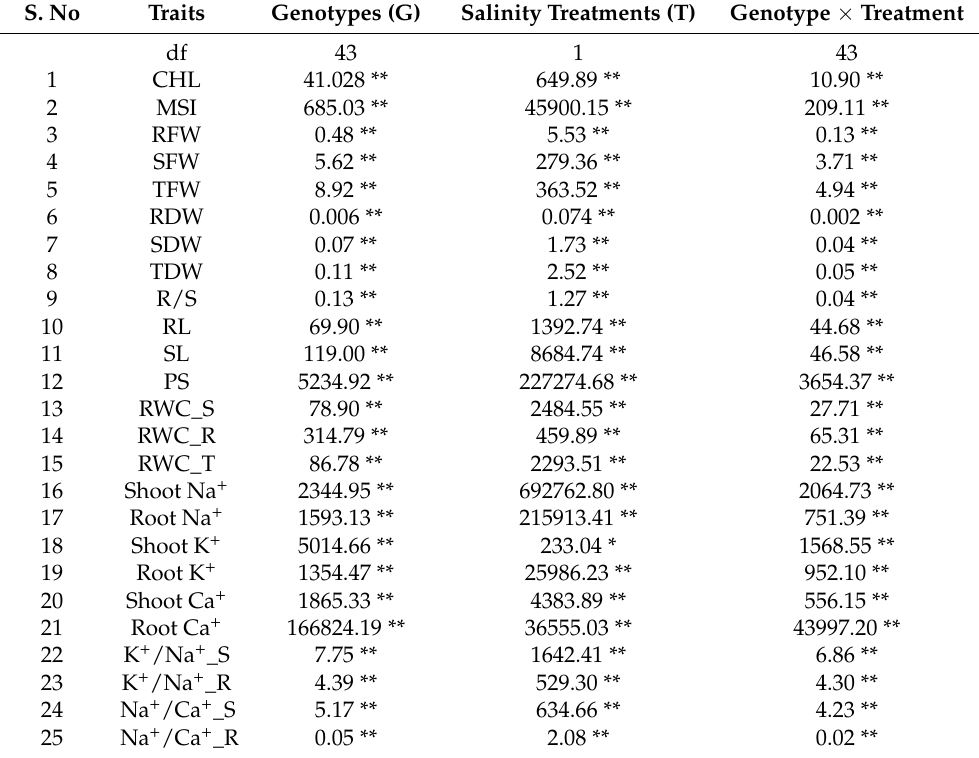
Table 1. Mean squares (MS) of the analysis of variance of all studied traits under salinity stress condition; CHL: chlorophyll, MSI: membrane stability index, RFW: root fresh weight, SFW: shoot fresh weight, TFW: total fresh weight, RDW: root dry weight, SDW: shoot dry weight, TDW: to- tal dry weight, R/S: root/shoot ratio, RL: root length, SL: shoot length, PS: photosynthetic rate, RWC_S: relative water content of shoot, RWC_R: relative water content of root, RWC_T: total